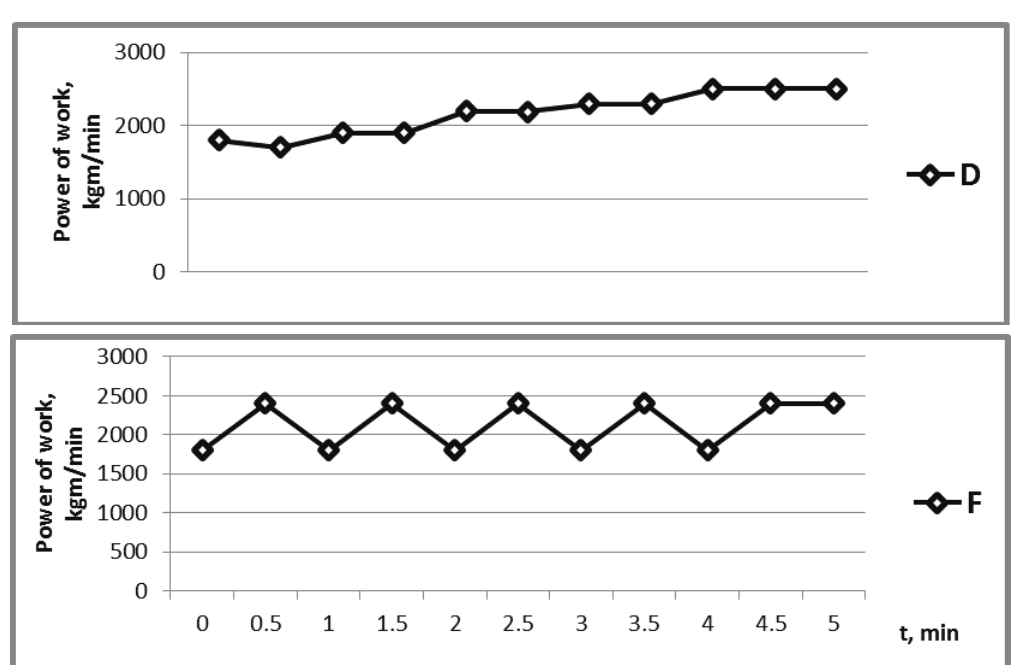
Fig. 2. Distribution of the actual pedal power at 30-second intervals: D — step-increasing power test; F — variable power